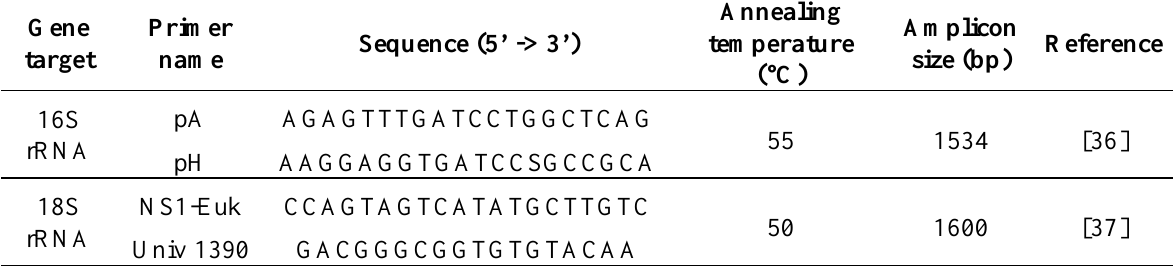
Table 1. Oligonucleotide primers used in this